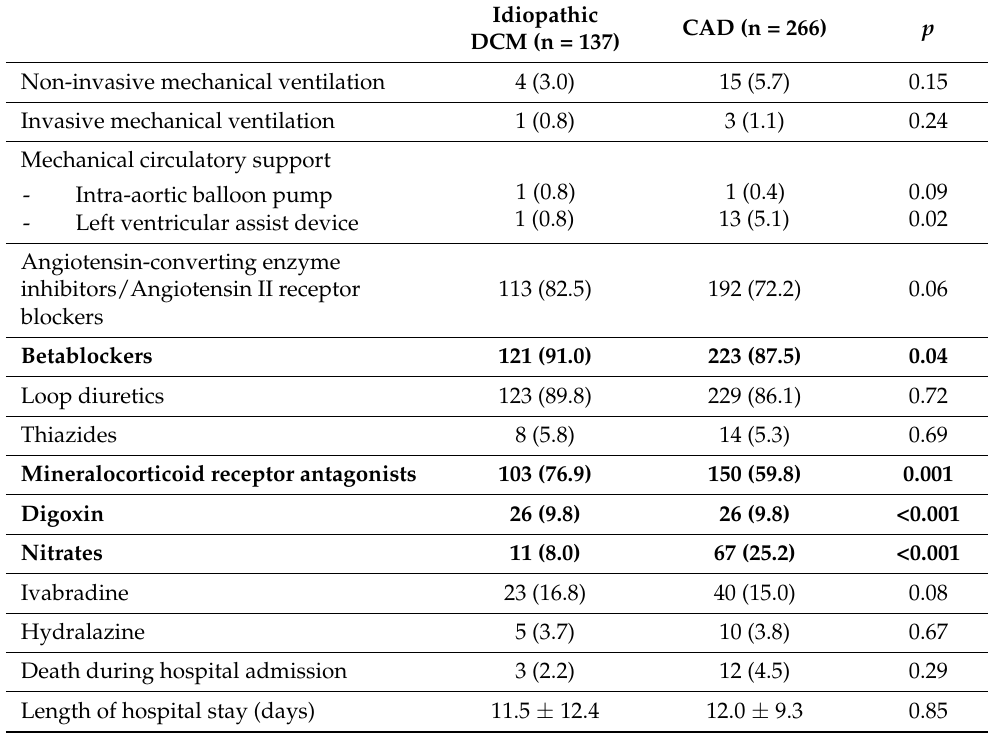
Table 2. Treatments during hospital admission and at hospital discharge.